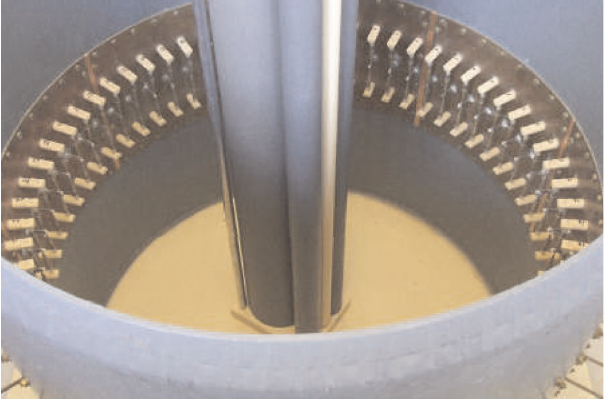
Figure 1: Synthetic dielectric object in the scanner.